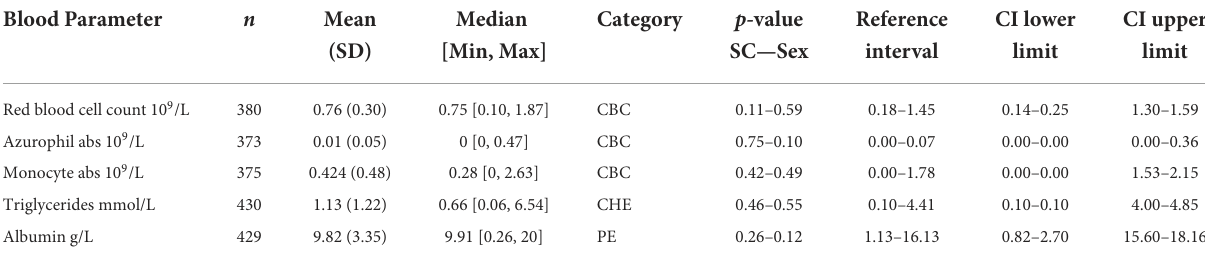
TABLE 2 American crocodile ( Crocodylus acutus ) hematological and biochemical general statistics and reference values with 90% confidence intervals (CI) for wild populations in South Florida, United States. Blood Parameter n Mean Median Category p -value Reference CI lower CI upper (SD) [Min, Max] SC—Sex interval limit limit Red blood cell count 10 9